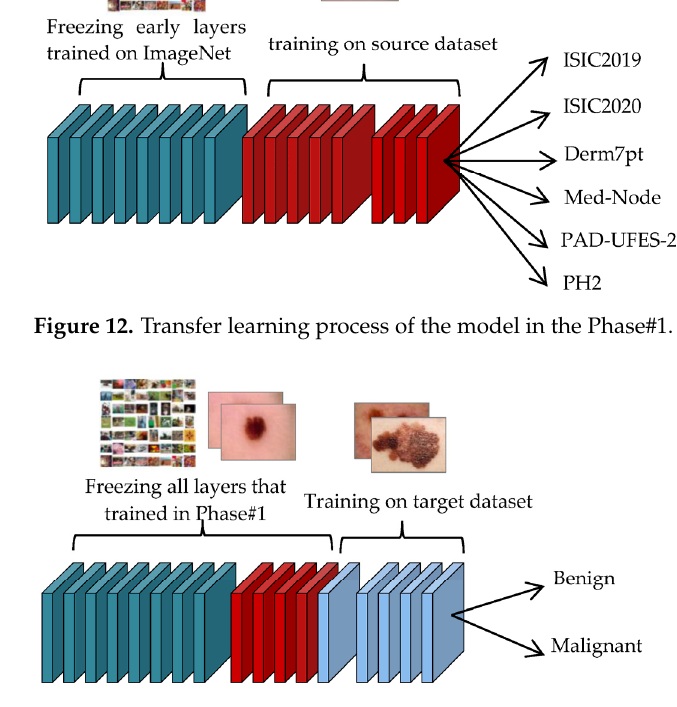
Figure 13. Transfer learning process of the model in the Phase#2.